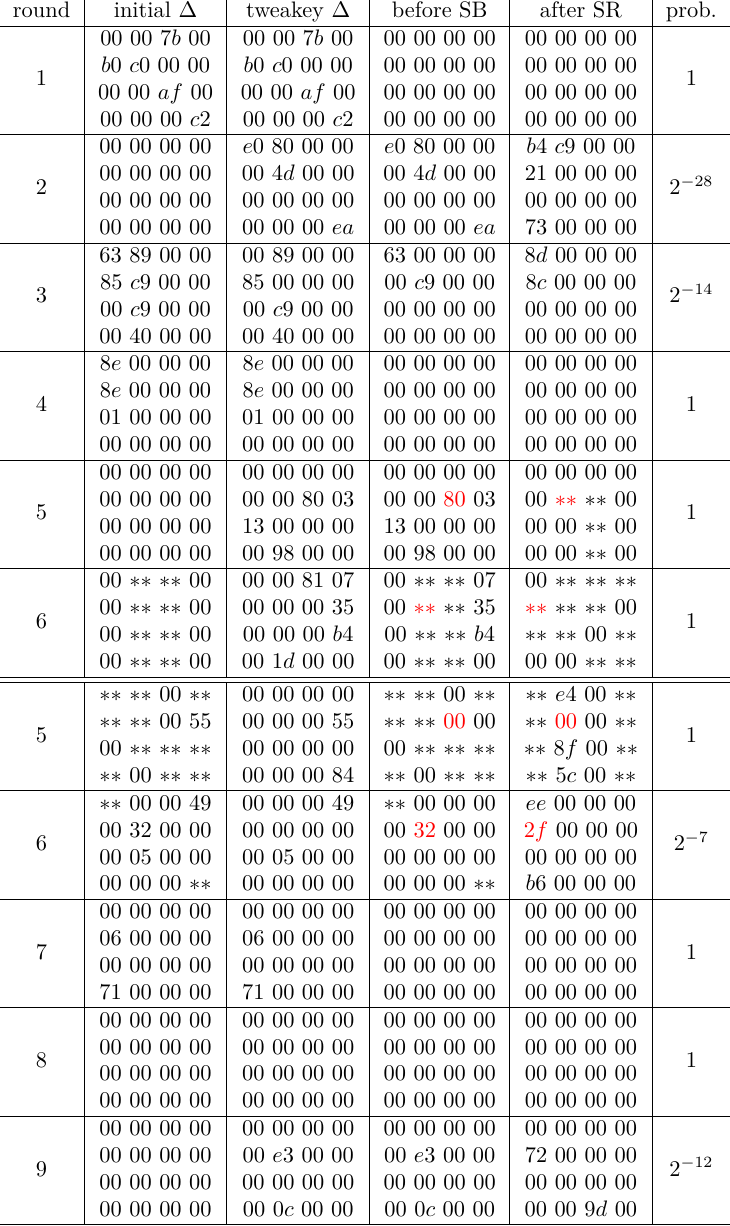
Table 6: The 9-round distinguisher of Deoxys -BC-256 from [CHP +